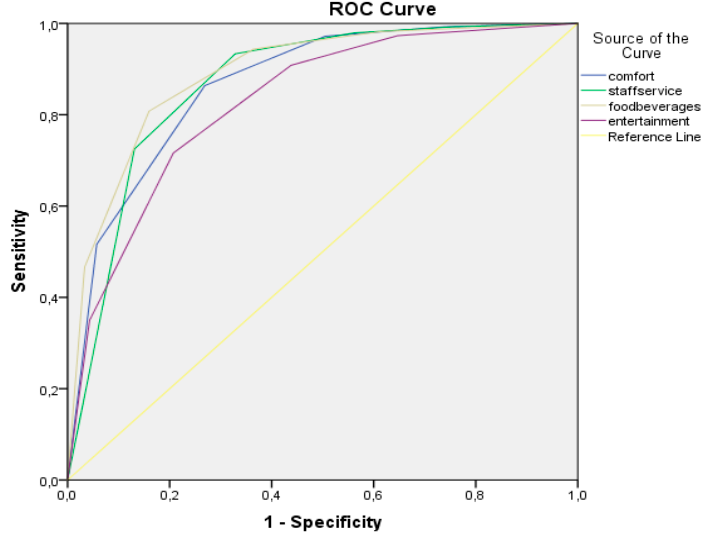
Figure 2. ROC Figure 2. ROC Curve. Table 5. Correct rate of classification.